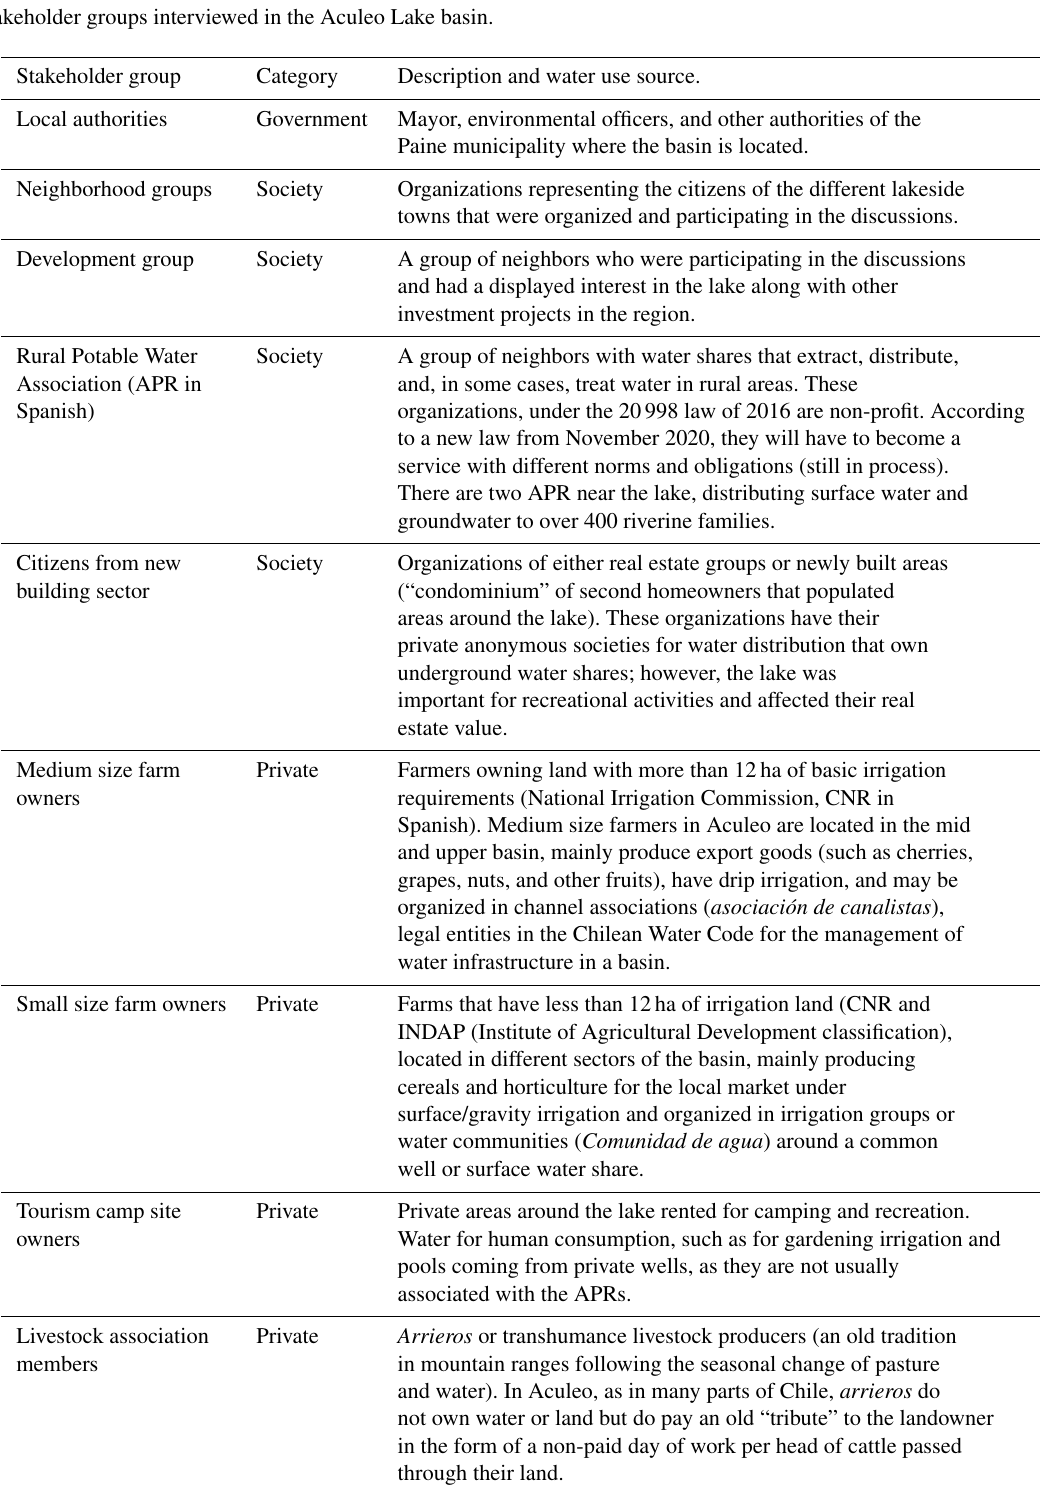
Table 1. Stakeholder groups interviewed in the Aculeo Lake